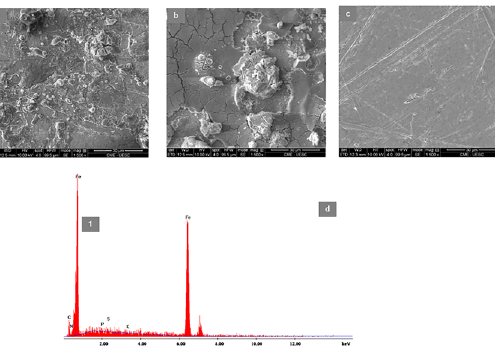
Figure 12. SEM images of CS-ASTM 1020 surface after 120 min immersion in 18.23 g L -1 HCl solution in the absence (a) and in the presence of 1.112 g L -1 of benzotriazole (b) or cocoa bark extract (c). EDS spectrum of the surface of the latter sample